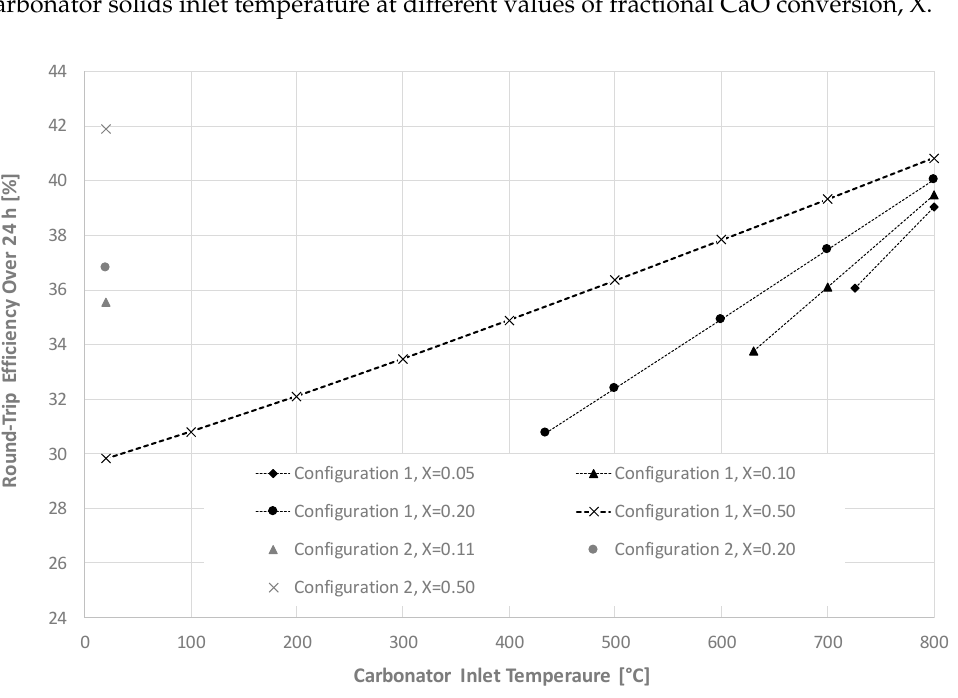
Figure 9. Operating limits for CaO conversion and carbonator solids inlet temperature at a supercritical steam cycle e ffi ciency of 40%.